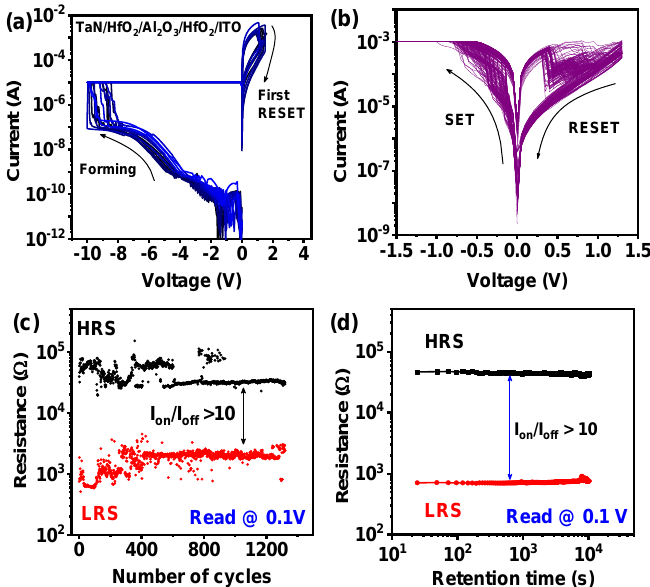
Figure 3. ( a ) Multiple initial forming characteristics under negative applied voltage to the top electrode and first RESET under positive voltage of TaN/HfO 2 /Al 2 O 3 /HfO 2 /ITO tri-layer RRAM device; ( b ) consecutive bipolar resistive switching characteristics of 200 SET/RESET cycles; ( c ) endurance characteristics of tri-layer RRAM device for 1300 switching cycles at a read voltage of 0.1 V; ( d ) memory retention of HRS and LRS for 10 4 s with a read voltage of 0.1 V.